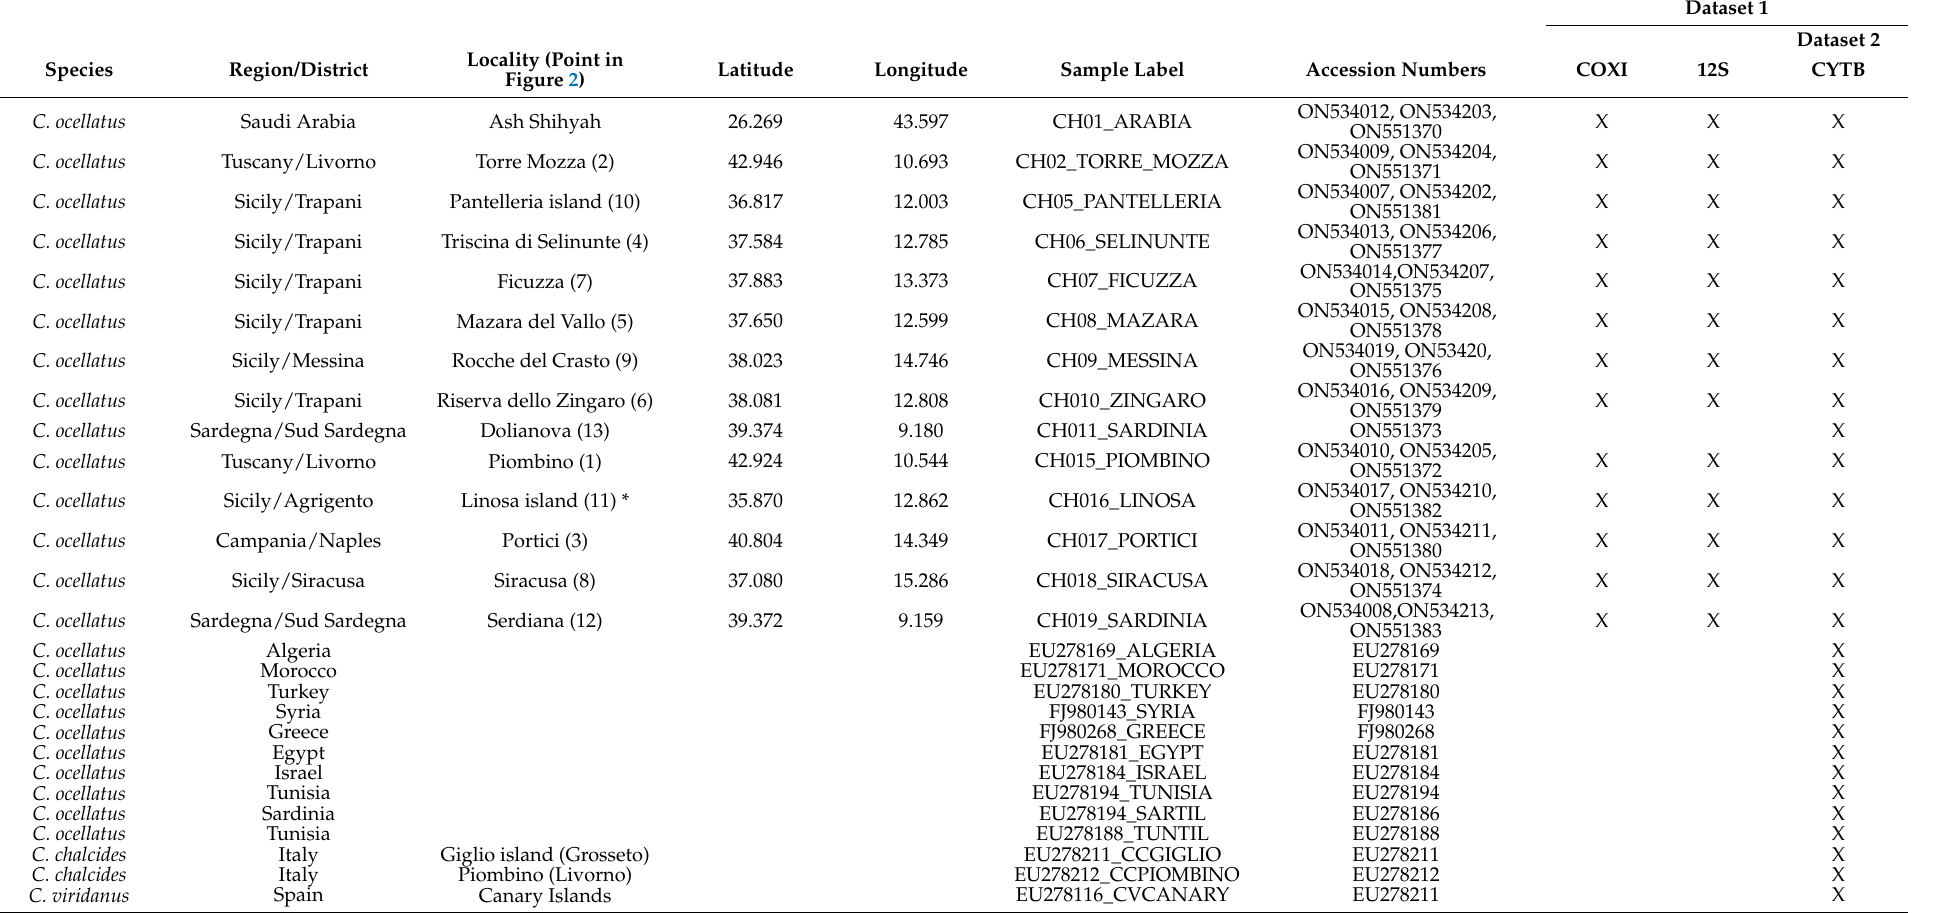
Table 1. Samples of Chalcides ocellatus and outgroups ( C. chalcides , C. viridanus ) included in our analyses, locality of collection, coordinates, amplified genes